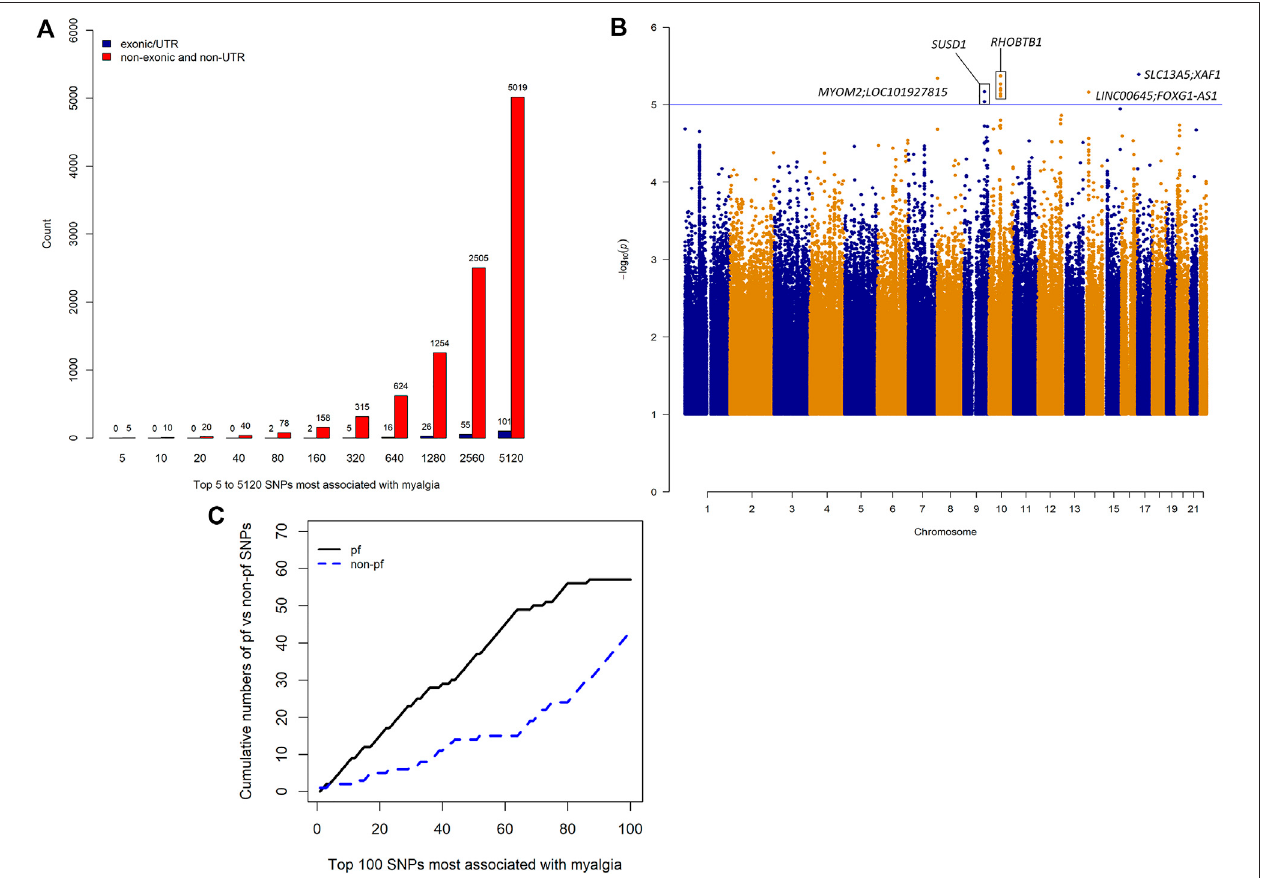
FIGURE 1 | Whole genome sequencing results. (A) Number of exonic/UTR variants vs non-exonic/non-UTR variants in the top 5 to 5,120 SNPs most associated withmyalgia. (B) ManhattanplotofassociationofSNPswithatorvastatin-inducedmyalgia.Thelineindicatesa p -valuethresholdof1 × 10 − 5 ,whichcanbeconsideredto beasuggestivethresholdofgenomewidesigni fi canceforsmallsamplesizes. (C) Cumulativenumbersofpotentiallyfunctional(pf)andnon-pfSNPsinthetop100SNPs most associated with myalgia.